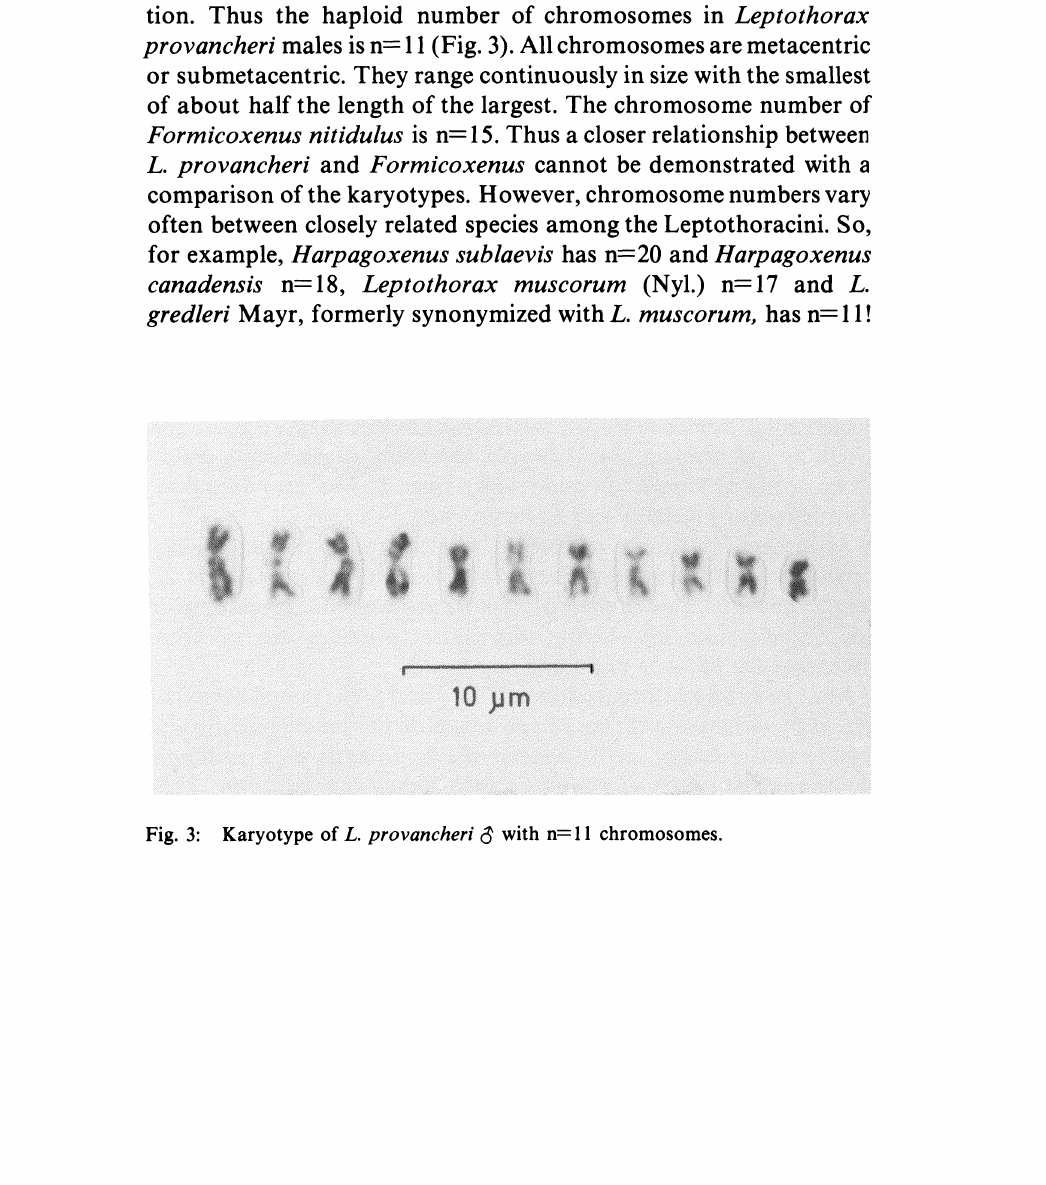
Fig. 3: Karyotype of L. provancheri